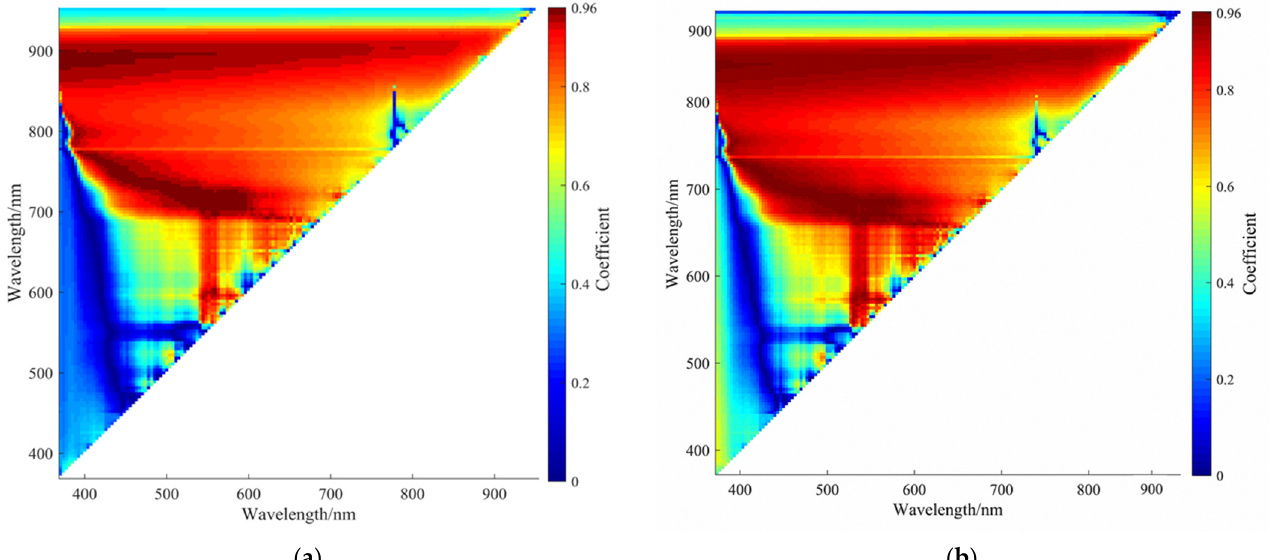
Figure 6. The correlation coefficient distribution, ( a ) is the distribution of the ratio correlation coefficient in the hyperspectral band; ( b ) is the distribution of the normalized ratio correlation coefficient in the hyperspectral band.